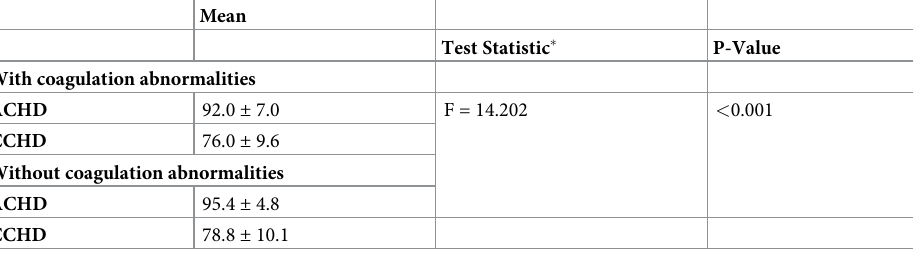
Table 5. Oxygen saturation levels in participants with uncorrected